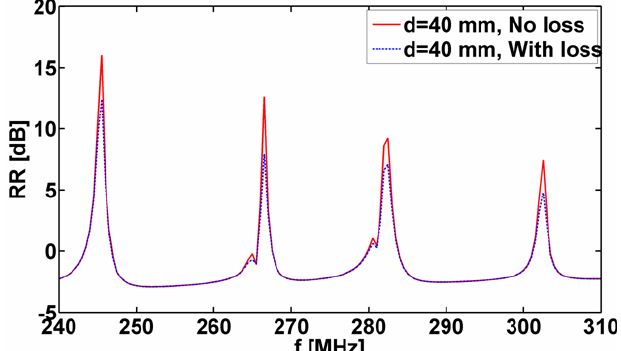
R |log10RR  [dB] as a function of frequency for the lossy Figure 9. The quantity | t 10 and lossless 4-cylinder structures for separation distance d = 40 mm. In all cases, the ELC d   . See the main text for further is located at )0,2/(),( o 1, Coss